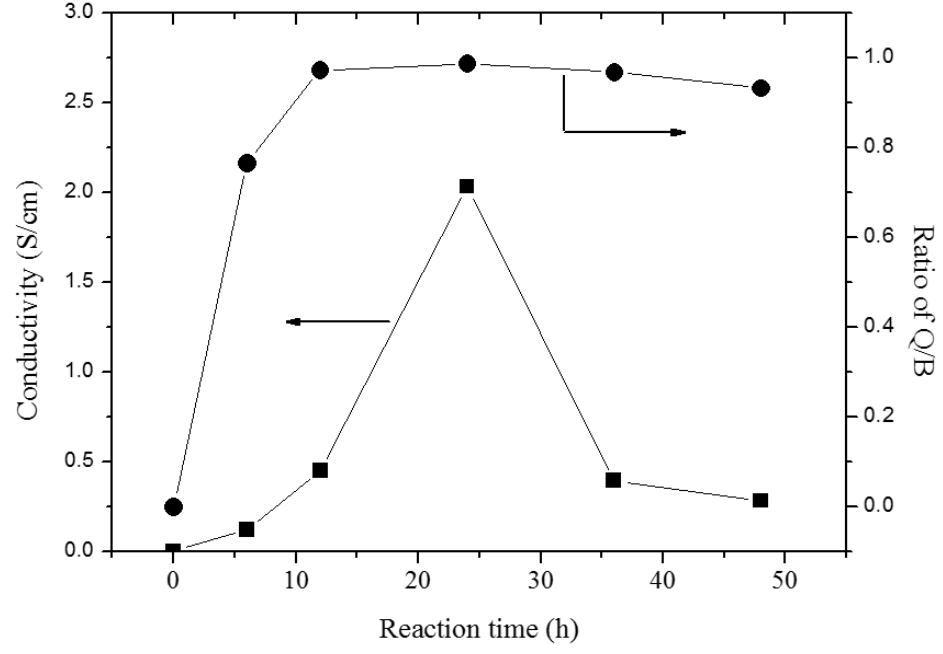
Figure 4. Relationship among reaction time, conductivity and the ratio of Q / B from FTIR (Fourier transform infrared) measurements. (Q / B: the ratio of area of peaks corresponding to quinoid (Q) and benzenoid (B) structure present in the PANDB).